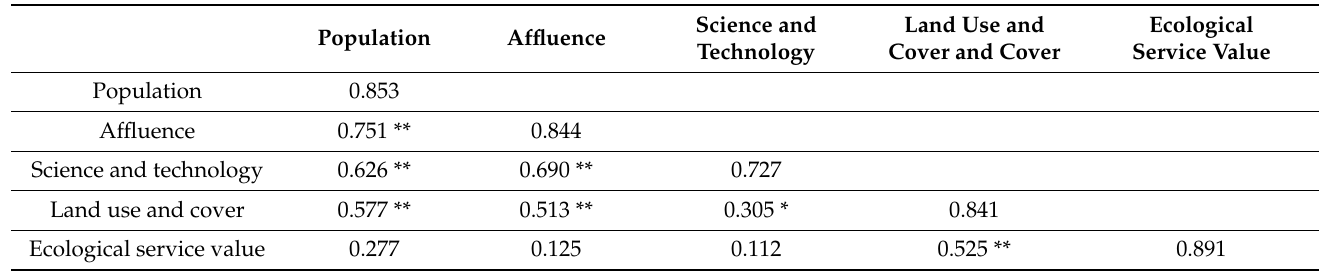
Table A1. Convergent validity and discriminant validity test.